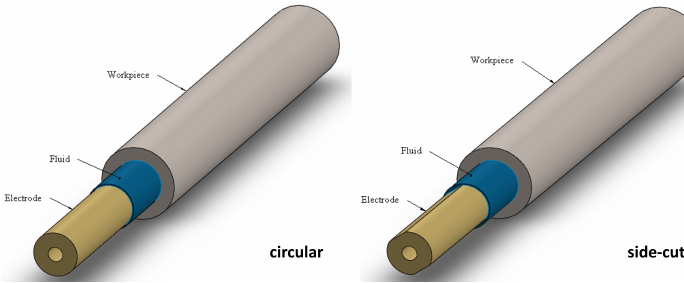
Figure 4. Solid models representing electrode-fluid-workpiece interaction.